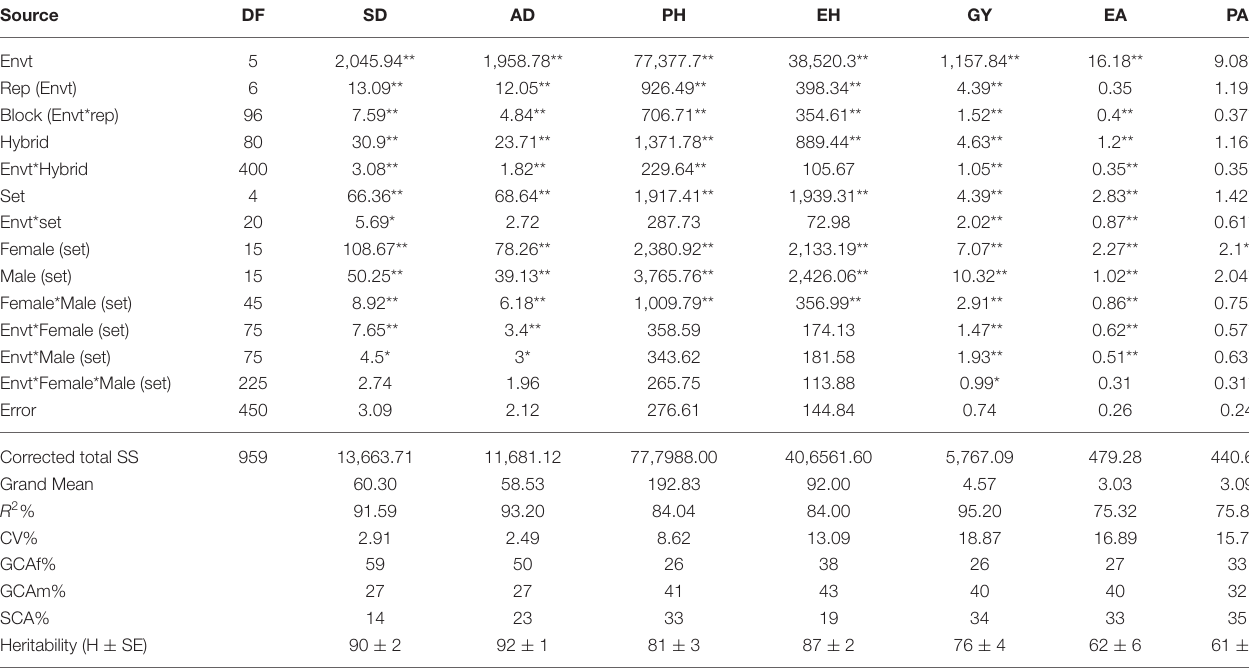
TABLE 4 | Summary of mean squares of combined ANOVA across environment for agronomic traits of 80 F1 hybrid maize progenies plus one commercial hybrid check.